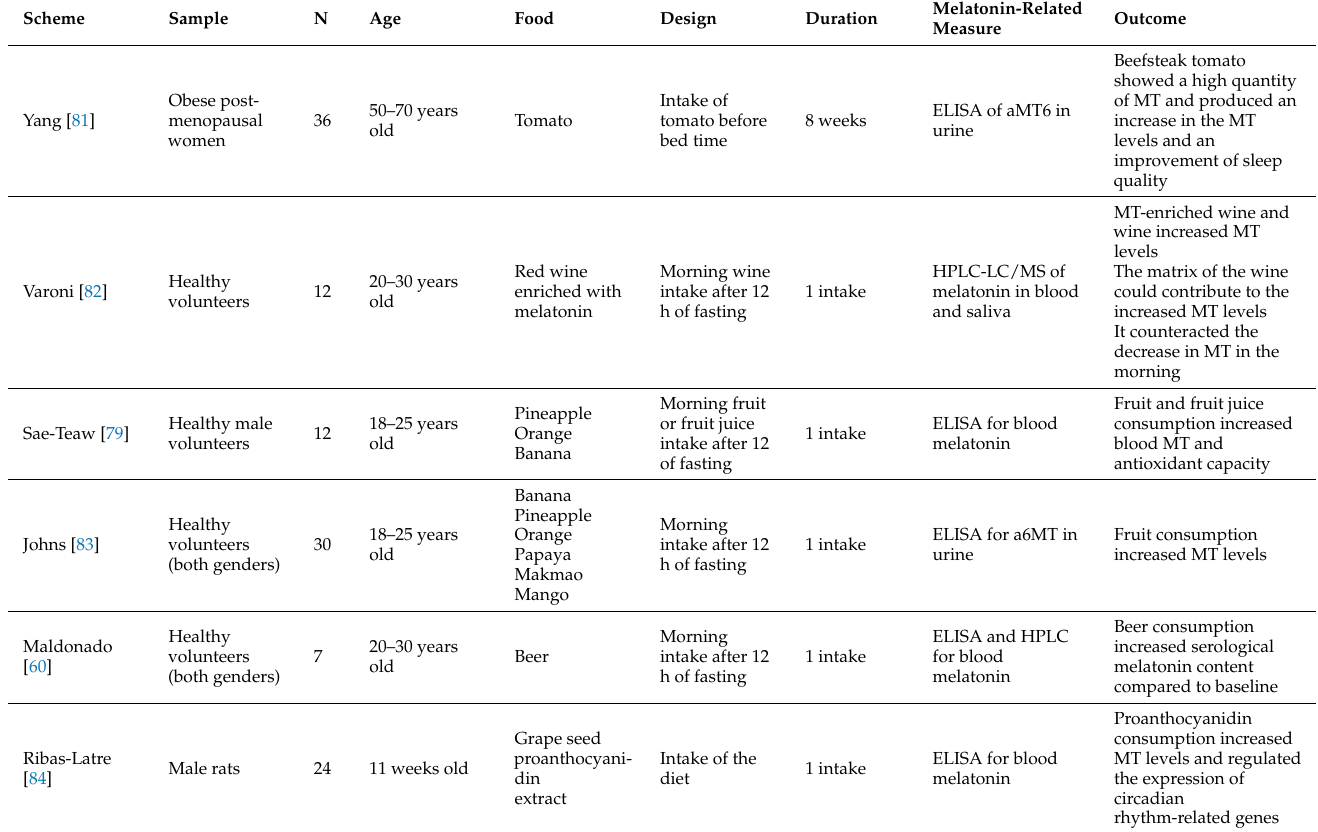
Table 5. Characteristics of the interventional